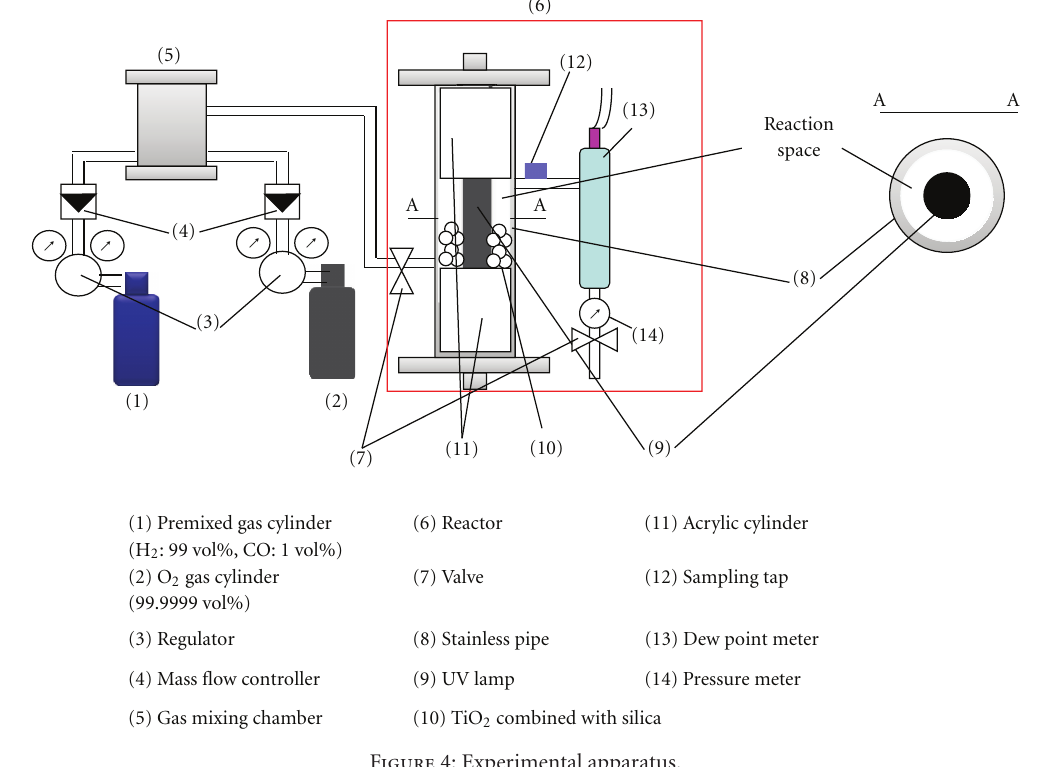
Figure 4: Experimental apparatus.